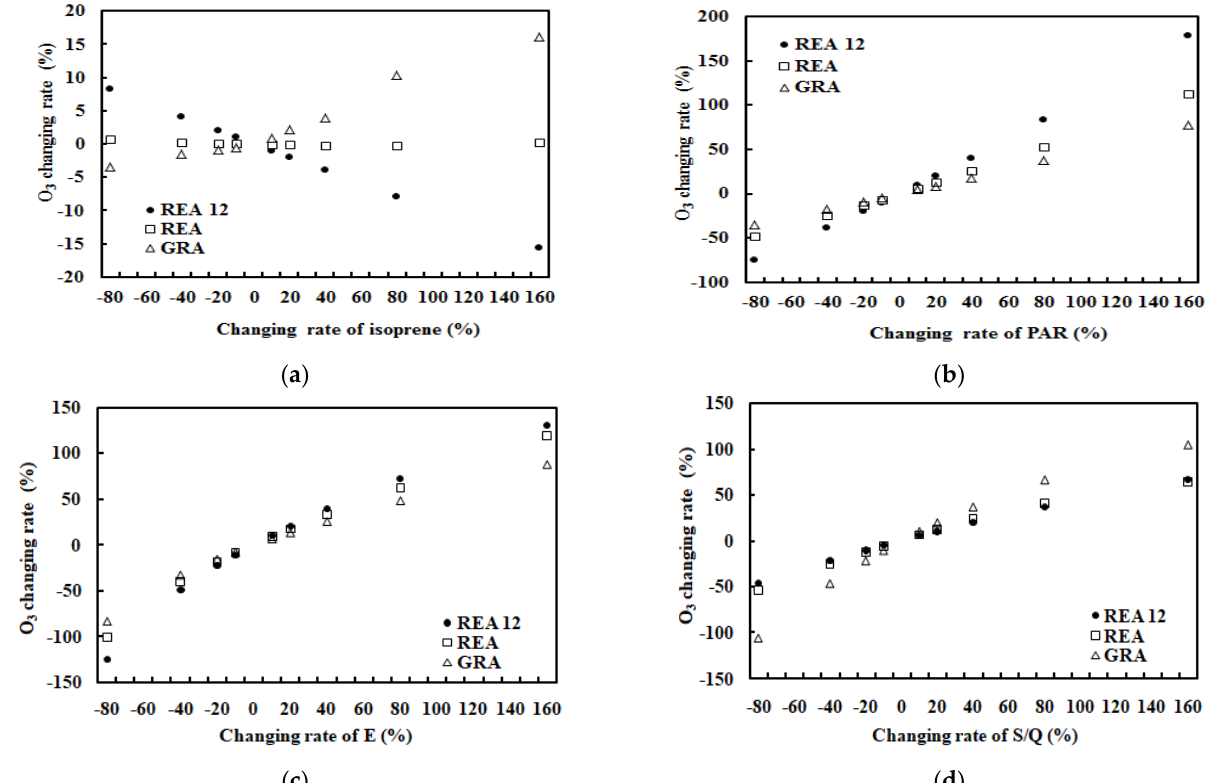
Figure 5. O 3 changing rates (%) with the change of one factor (isoprene, or PAR, E, S/Q for situations of ( a – d ), respectively) and other factors kept at their original levels under realistic atmospheric conditions, REA and GRA denote the emission data measured by REA and gradient technique, respectively. REA12 denotes the isoprene emission data used in model development (O 3 empirical model considering isoprene